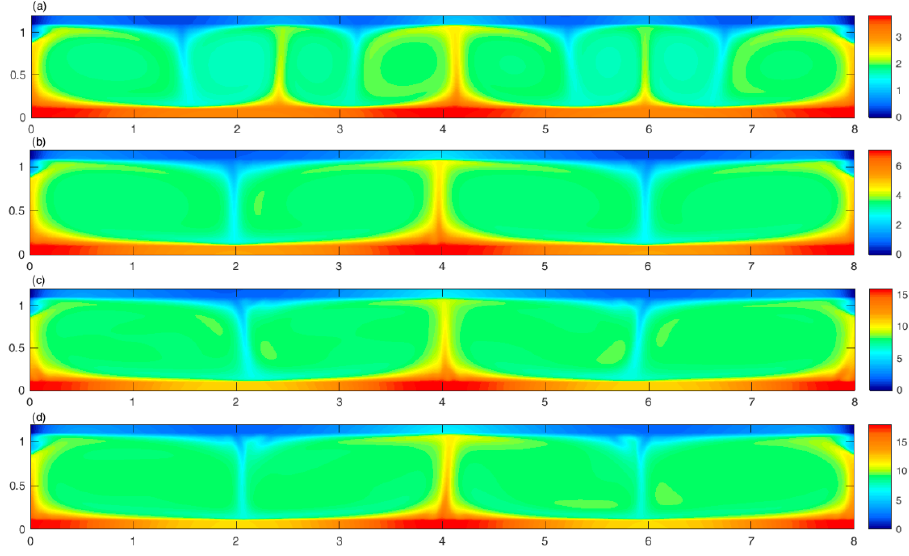
Figure 10. Iso-thermal contours for Ra = 106, at time period of ( a ) 0.5 s, ( b ) 1 s, ( c ) 4 s, ( d ) 9 s.